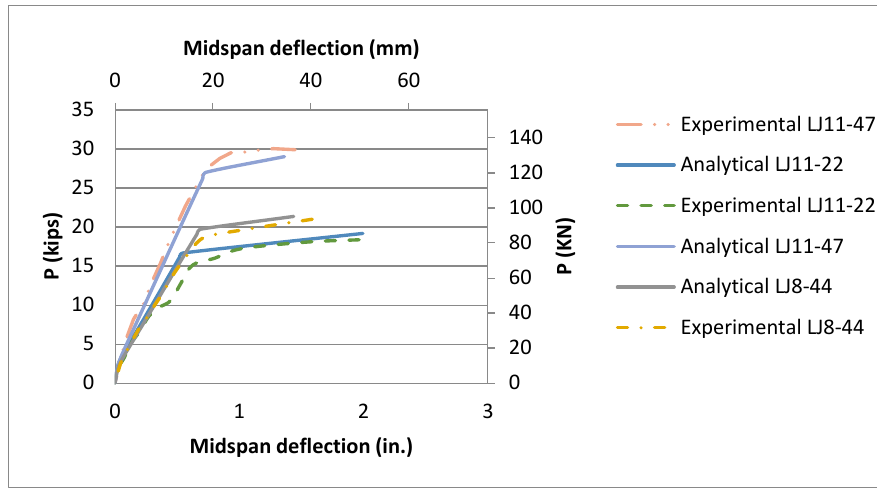
Figure 15. Ahmad and Batts (1991) [17] load vs. midspan deflection comparisons.